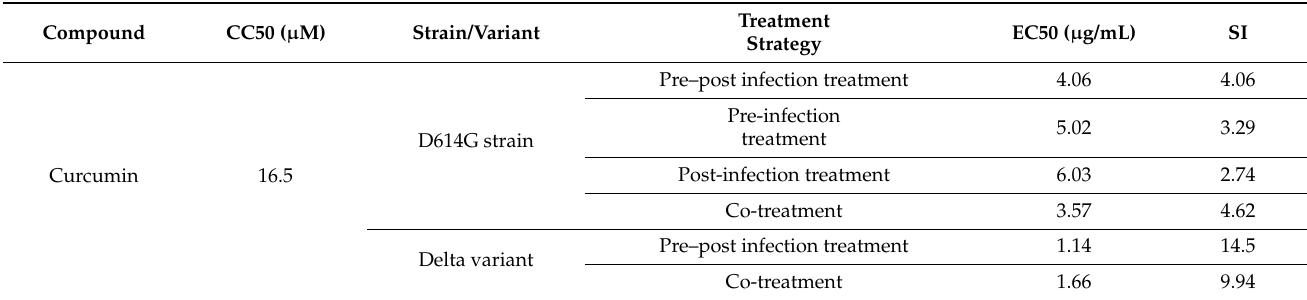
Table 1. CC50, EC50, and SI values for curcumin in Vero E6 cells infected with SARS-CoV-2. Compound